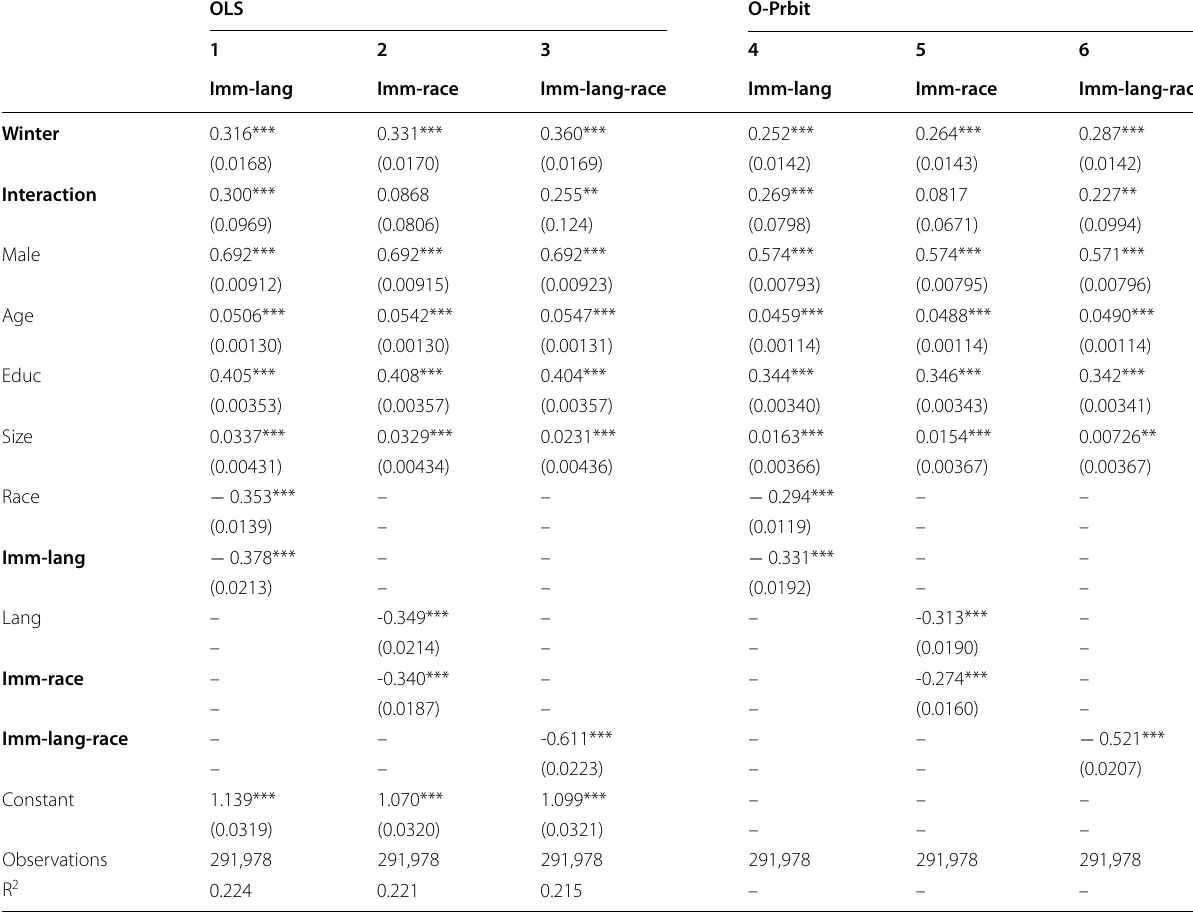
OLS indicates OLS results, O-Probit indicates Ordered Probit results. Lower-level column names indicate the variable used as diff ij . Standard errors are reported in parentheses. Variables of interest are in bold. Control variables include age, education, gender, household size, race, province and year fixed effects. Survey’s personal- level weights are used in the estimation. Significance at the one, five and ten percent level are indicated by three, two and one asterisks,